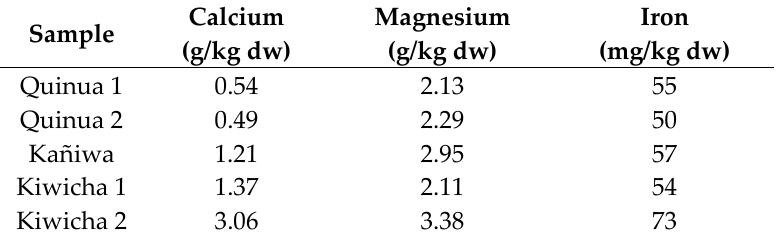
Table 5. Content of minerals in Andean